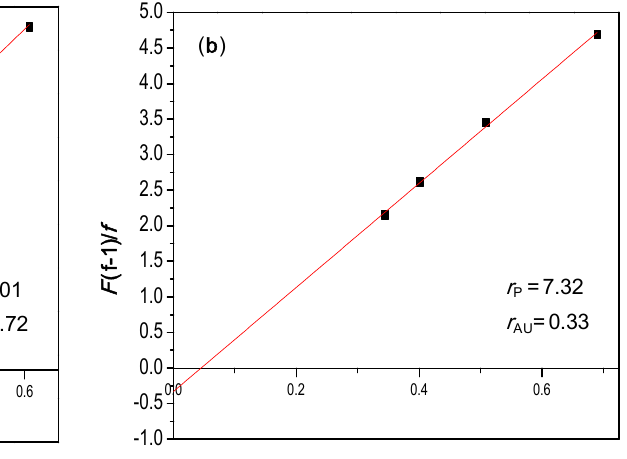
Figure 3. Cont. Figure 3. Cont.